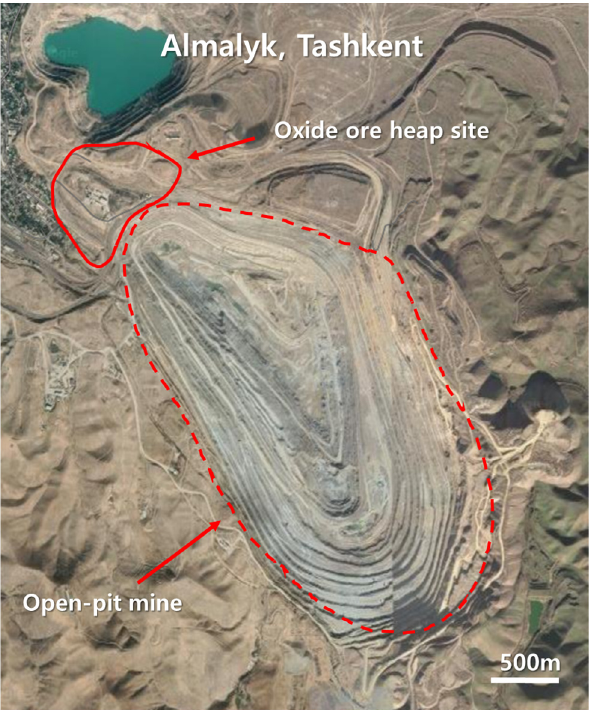
Figure 1. Location of the oxide heap in Almalyk mine,